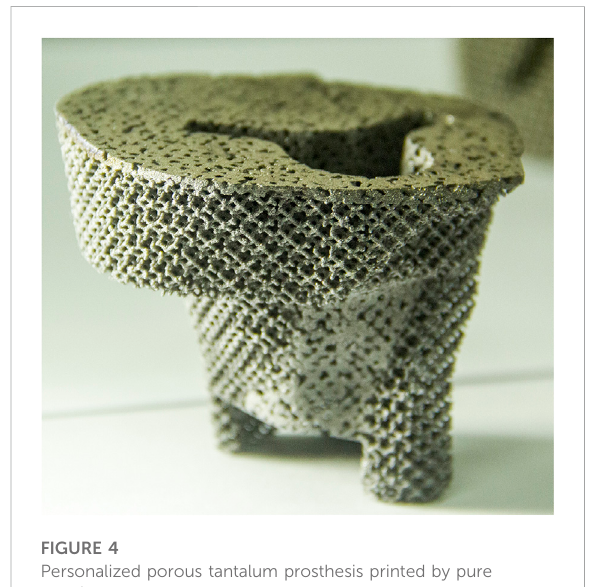
FIGURE 4 Personalized porous tantalum prosthesis printed by pure